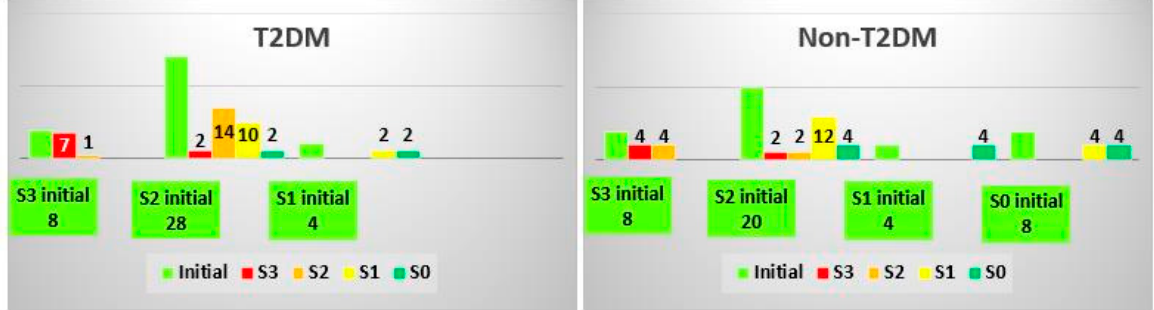
Figure 4. Changes in the SteatoTest class after treatment in the T2DM and non-TDM2 groups.